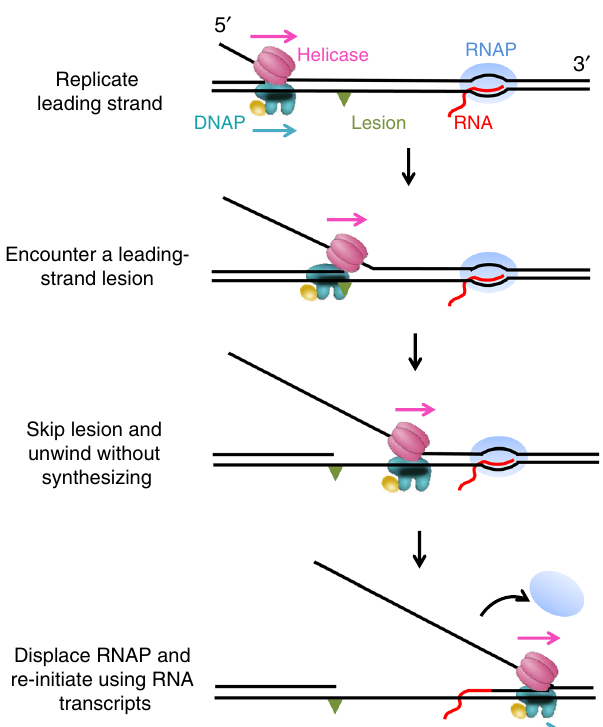
Fig. 5 Proposed T7 replication re-initiation model. Cartoons illustrate a proposed model for T7 replication re-initiation. The replisome here consists of leading-strand DNAP and helicase. When the replisome encounters a leading-strand lesion, helicase may continue to unwind processively via association with a non-replicating DNAP. The two proteins form a complex clamping crossed the fork junction, poising the DNAP for replication re- initiation. After collision with a TEC, the helicase-DNAP displaces the RNAP and the DNAP then uses the RNA as a primer to re-initiate the